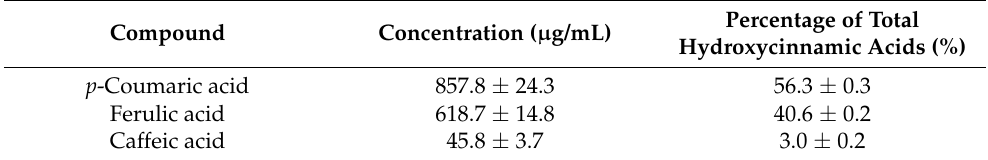
Table 5. Re-calculated values of hydroxycinnamic acids of concentrated ethanolic propolis extract.